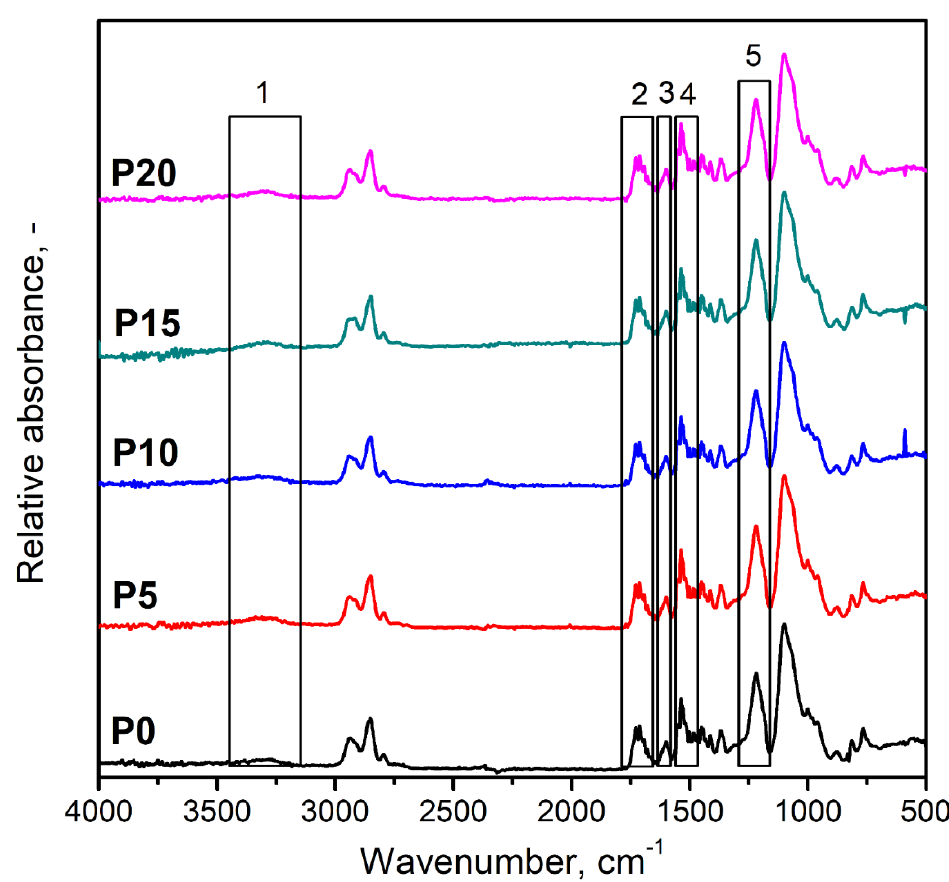
Figure 3. FTIR spectra of prepared PU/GTR composite foams and the unmodified PU foam.